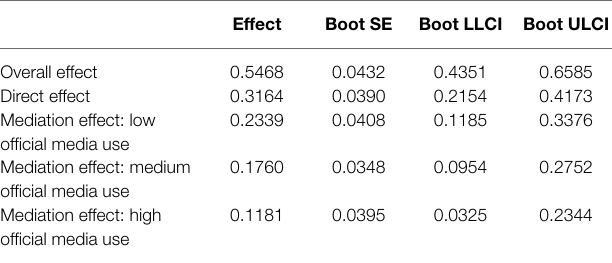
TABLE 4 | Direct effects, indirect effects and overall